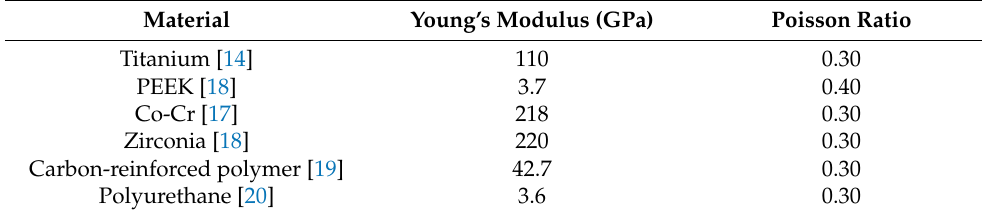
Table 1. Mechanical properties of the materials.